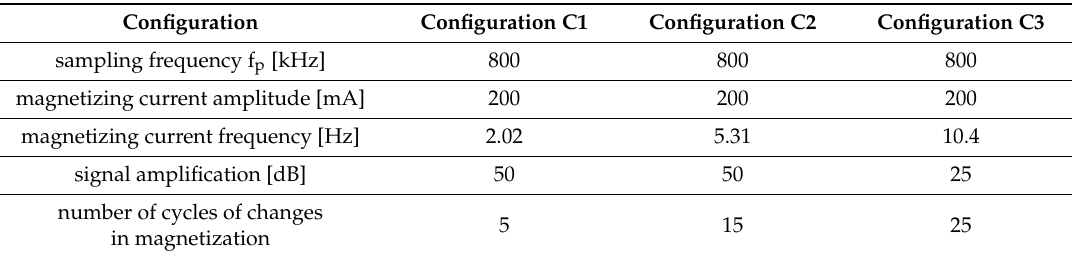
Table 3. Details of the measuring configuration.